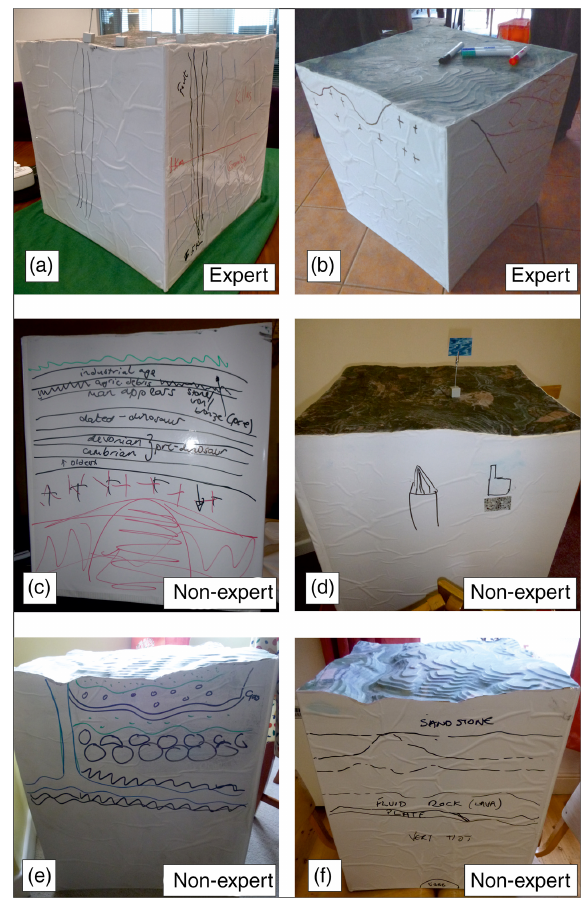
Figure 4. Images of 3-D participatory models completed by expert and non-expert participants. (a) Eric – an expert participant – rep- resents the expert model, with a logical diagram utilising more than one side of the model (including the surface), with detail provided by numerical and factual annotation. (b) Edward – an expert partic- ipant – also demonstrates an expert model, with a representation of a fault structure displayed at the surface and symbols used to iden- tify different rock types. (c) Kimberley – a non-expert participant from Carharrack – conceives the subsurface in a couple of interest- ing ways. Firstly, the red shading is used to depict the Earth’s core, initially as a semi-circular shape and then later modified to match the linear appearance of the rest of the diagram. In addition, the diagram shows some uncertainty about the inferred ground level, which is drawn with a green zigzag line, below the actual surface of the model. (d) Katie – a non-expert participant from Carharrack – presents a much sparser diagram, with subterranean buildings em- phasising the human interaction with subsurface space. (e) Charlotte – a non-expert participant from Chulmleigh – drew a direct link be- tween the surface and the subsurface in the form of a channel that connects the topographic low (where the river is shown on the aerial photograph) and an underground body of water, which cuts across the entire model. Finally, (f) Charles – a non-expert participant from Chulmleigh – shows another model which has been interpreted to represent a more scientific model, with the Earth’s core represented at the bottom and the different layers as approximations of differ- ent scales of geological concepts, from tectonic plates to erosional surfaces of